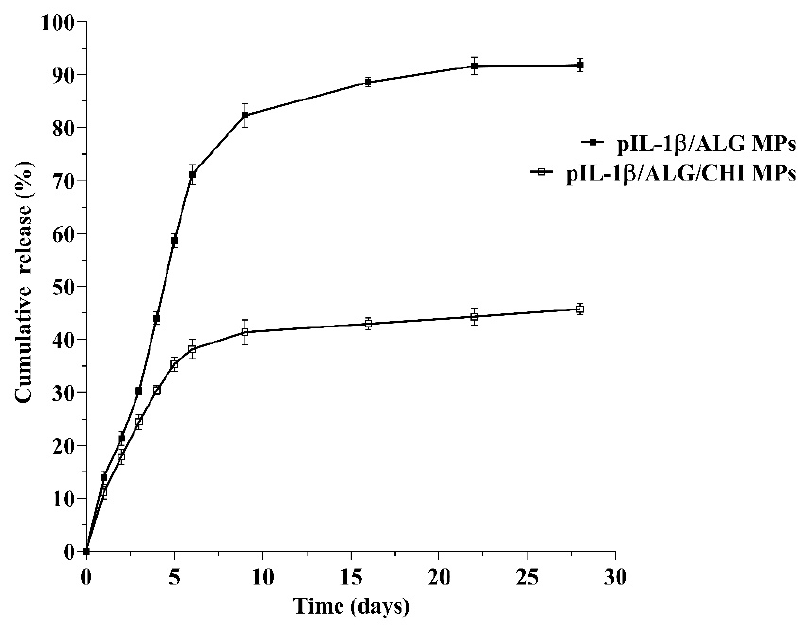
Figure 8. Cumulative release of pIL-1 β from alginate MPs ( (cid:4) ) and chitosan-coated alginate MPs ( (cid:3) ) in PBS at pH 7.4. Data represent the mean ± standard deviation ( n =